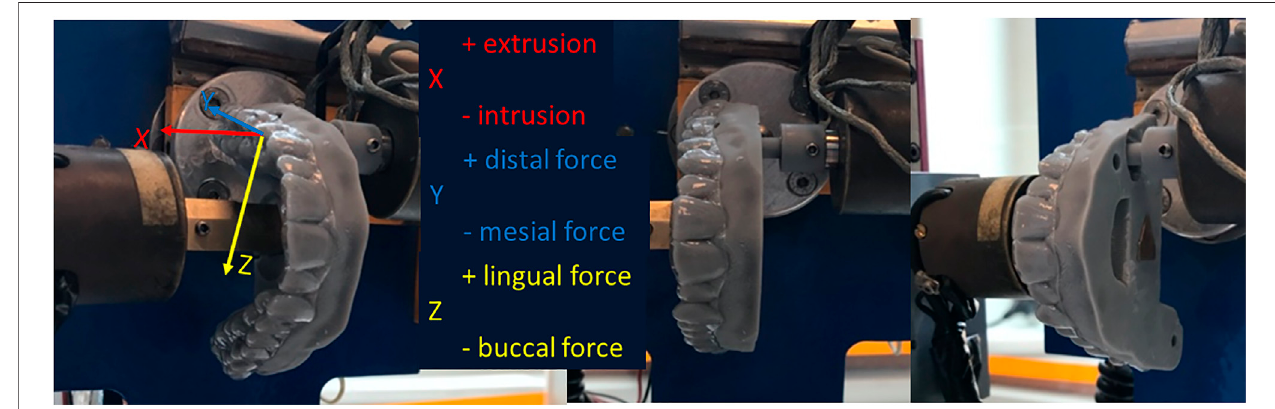
FIGURE2| Overviewofthetestingset-up.Sensor1(rotatingtoothcarryingdifferentattachmentdesign,seenontheright)andSensor2(stablebasemodel,left)in action. Each aligner corresponding to the speci fi c attachment was mounted in the “ test position ” which was reproduced for all tests by the same FSI software coordinates. The three axes: X: long axis of the tooth; Y: mesio-distal axis; and Z: bucco-lingual axis are represented for